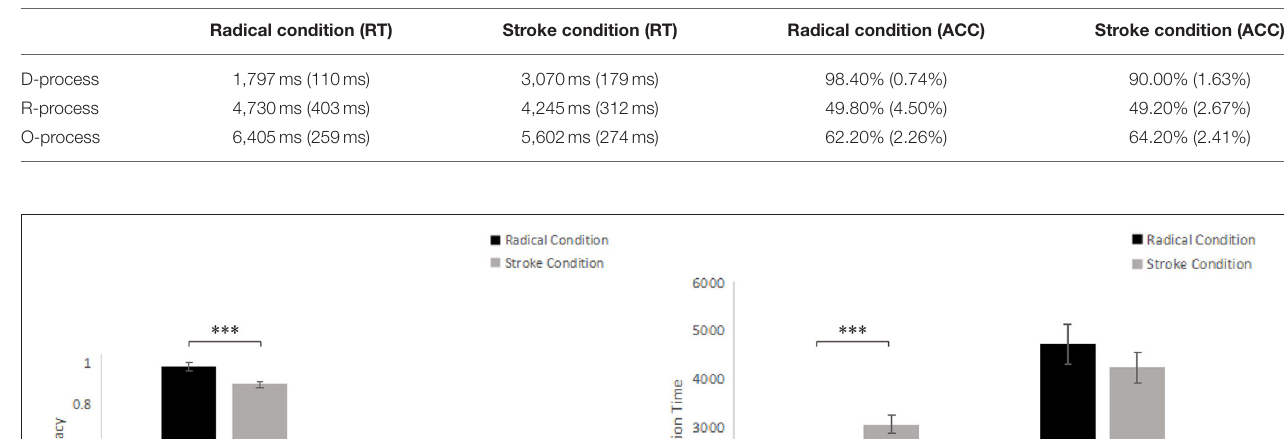
TABLE 1 | Reaction time and accuracy of the three tasks, with standard error in parentheses.